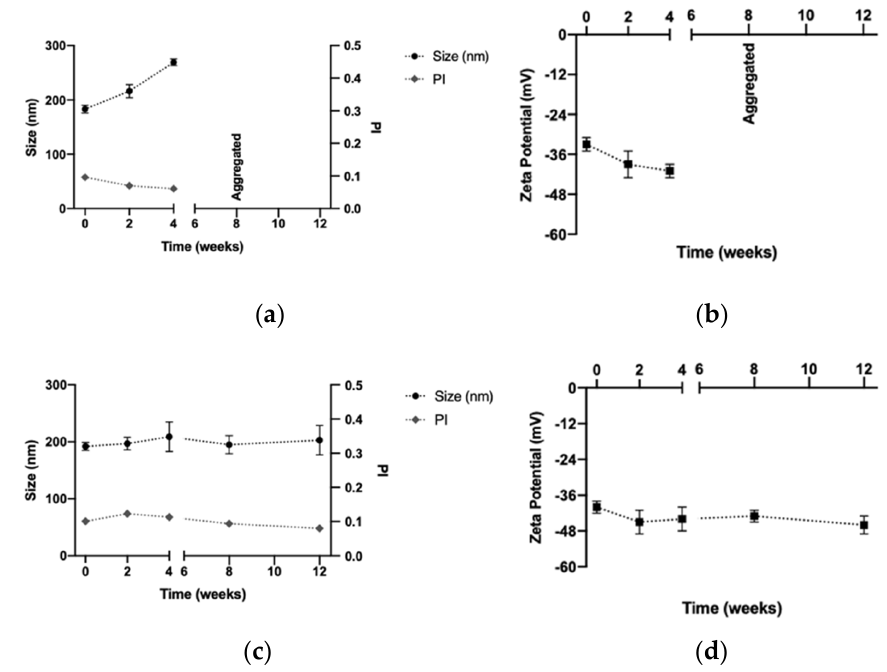
Figure 7. Stability of the dextran nanocapsules with imiquimod in their core (DX NC-imq*) subjected to freeze-drying and stored at room temperature. ( a , b ) Size, polydispersity index and zeta potential of DX NC-imq* freeze-dried with glucose at 10%, respectively. ( c , d ) Size, polydispersity index and zeta potential of DX NC-imq* freeze-dried with trehalose at 10%, respectively. PI: polydispersity index. * Formulation elaborated applying high manual pressure. (Mean ± SD, n = 3).